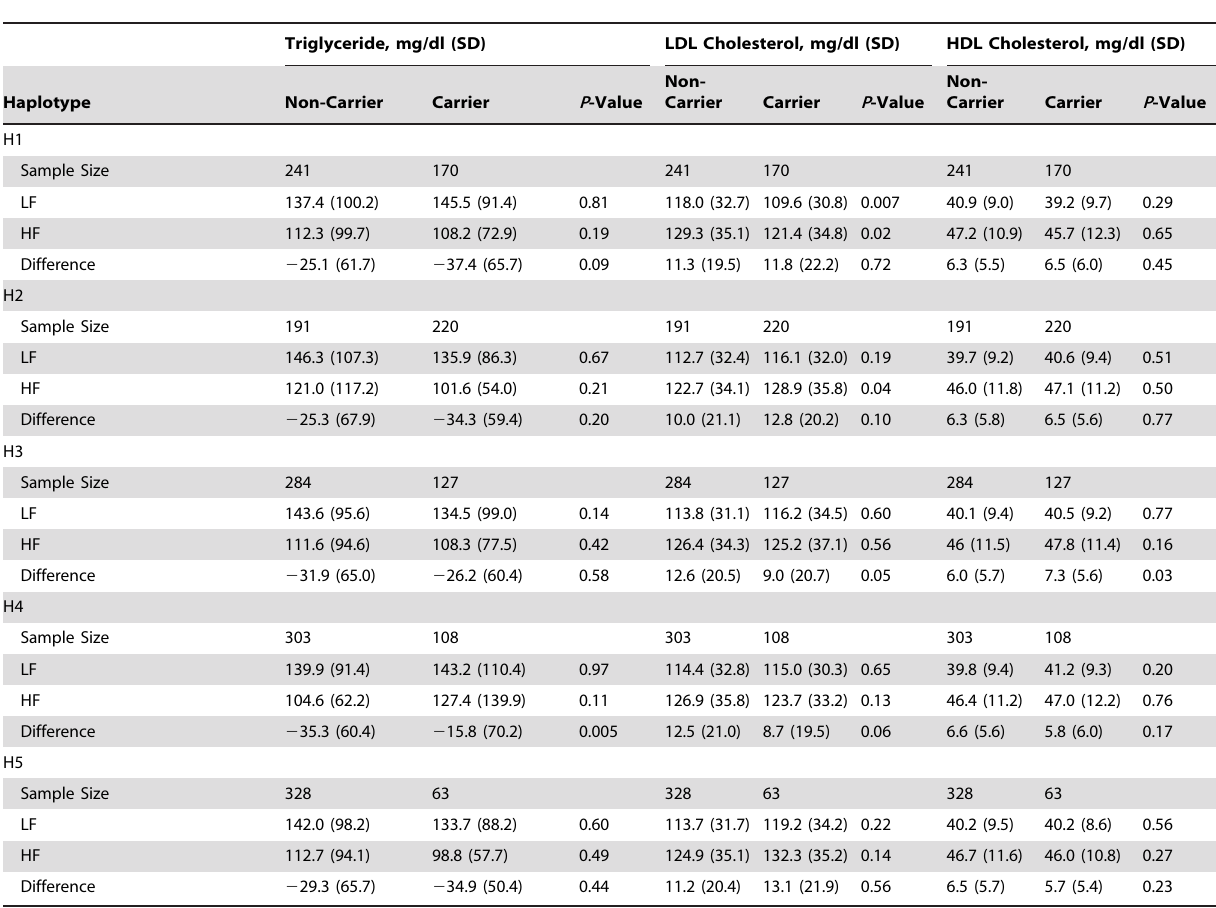
Table 2. Effect of haplotype on triglycerides, LDL-cholesterol and HDL-cholesterol in 411 normal to overweight males (Cohort # 1) on eucaloric